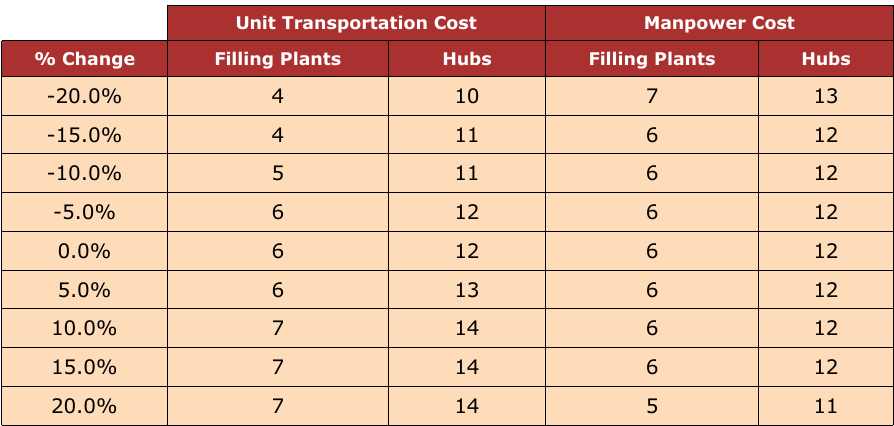
Table 3. Cost Sensitivity Analysis for test case 2